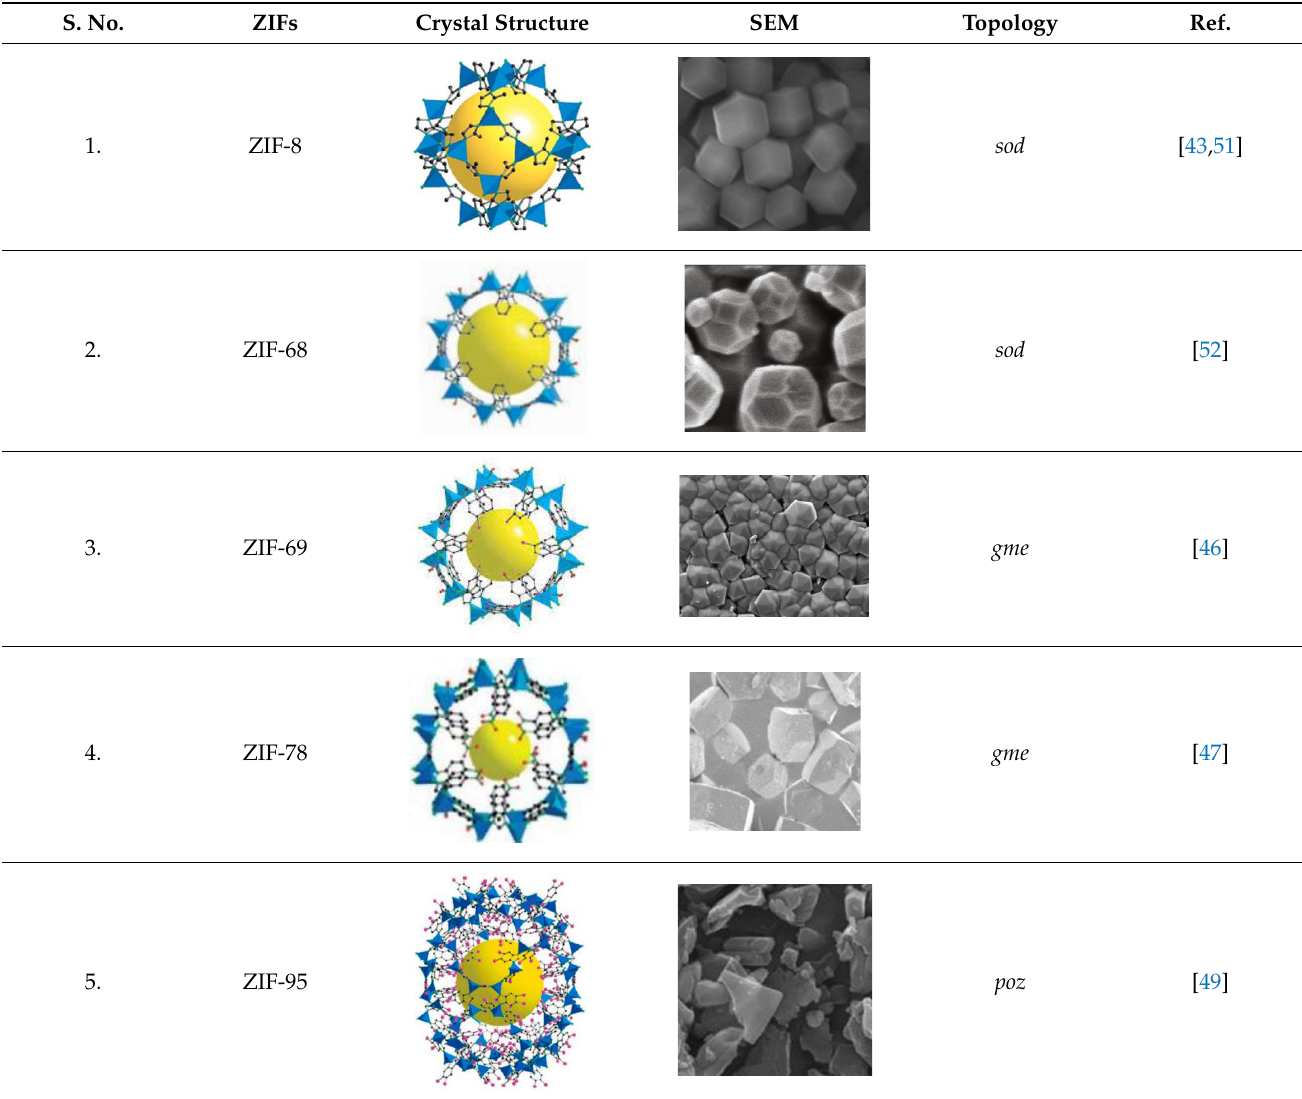
Table 2. ZIFs and their observations after SEM.